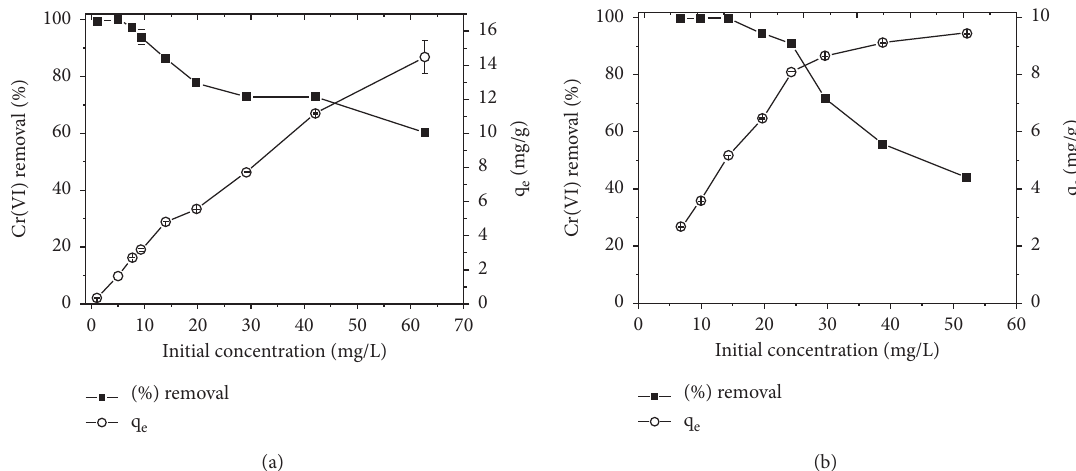
Figure 9: Effect of initial concentrations on adsorption of Cr(VI) onto TR (a), PSS (b) at optimum pH, shaking speed 200rpm, adsorbent dose 2.5g/L, and temperature 25 ° C.